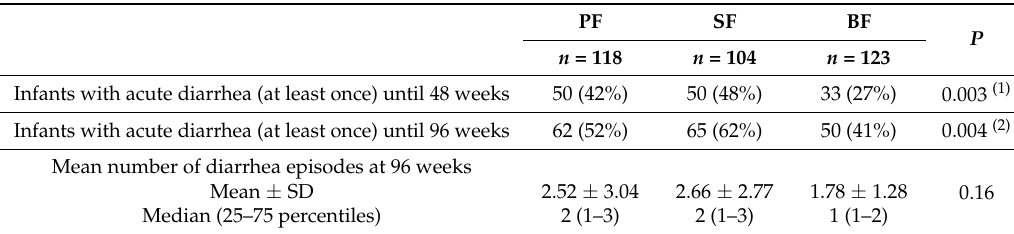
Figure 3. Percentage of infants with at least one episodes of respiratory infections (RI) at 48 and 96 weeks, with recurrent RI (RRI) until 96 weeks and with wheezy lower RI (WLRI) until 96 weeks of life. Table 4. Respiratory infections (RI) parameters and incidence of wheezy lower RI among the three Table 5. Acute diarrhea in the three nutritional groups.